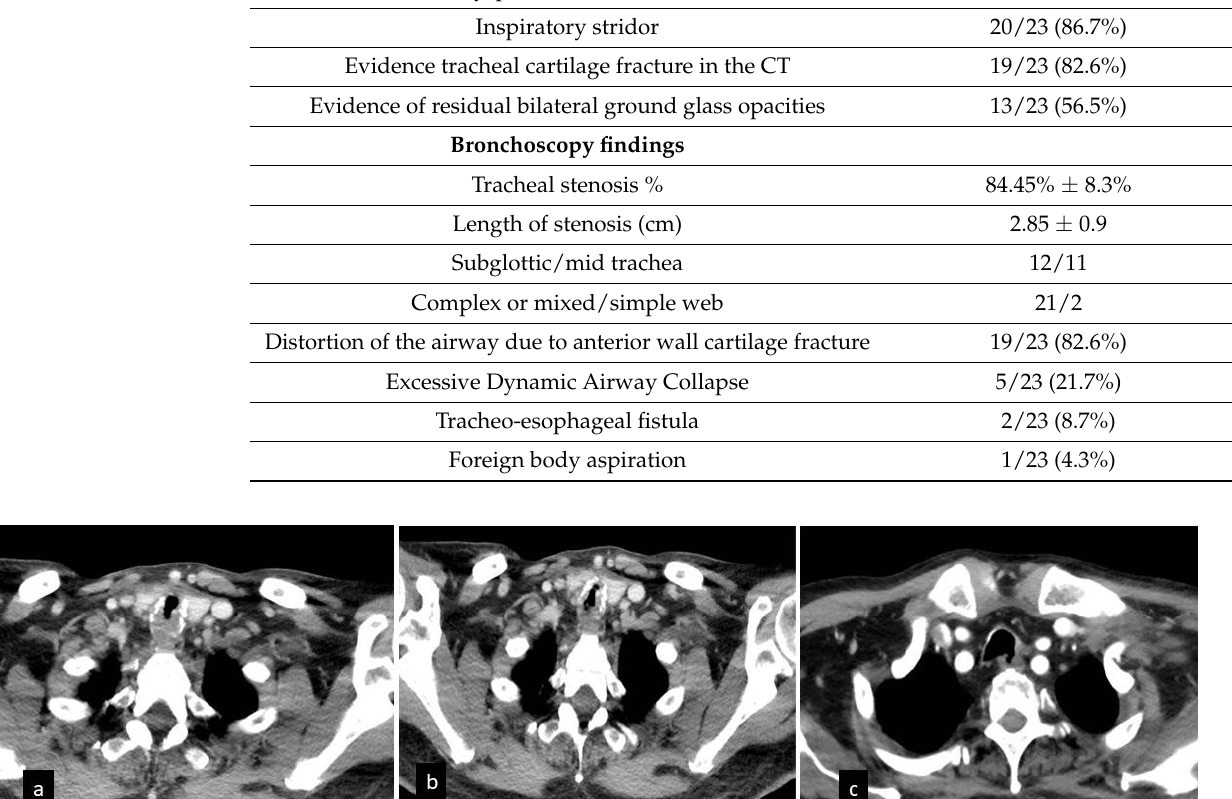
Figure 1. CT of the thorax depicting upper trachea stenosis with posterior wall thickening ( a ), anterior wall cartilage fracture ( b ) and tracheoesophageal fistula ( c ).